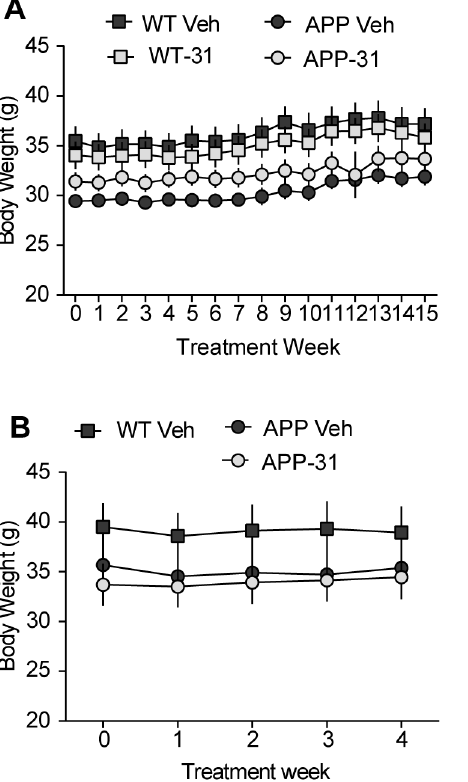
Figure 1. Body weight is not affected by treatment with LM11A-31 in male APP L/S mice. Body weights of ( A ) 9–11 month old male APP L/S mice treated with LM11A-31 (50 mg/kg) for 3 months (WT Veh, n=9 mice; WT-31, n=10; APP Veh, n=10; APP-31, n=9) and ( B ) 13–14 month old male APP L/S mice treated with LM11A-31 (50 mg/kg) for 1 month (WT Veh, n=5 mice; APP Veh, n=4; APP-31, n=5). APP mice weighed significantly less than WT mice in both of the age groups examined. LM11A-31 did not affect body weight at either age or genotype. Statistical significance was determined using repeated measures ANOVA with Dunnett’s post-hoc test.